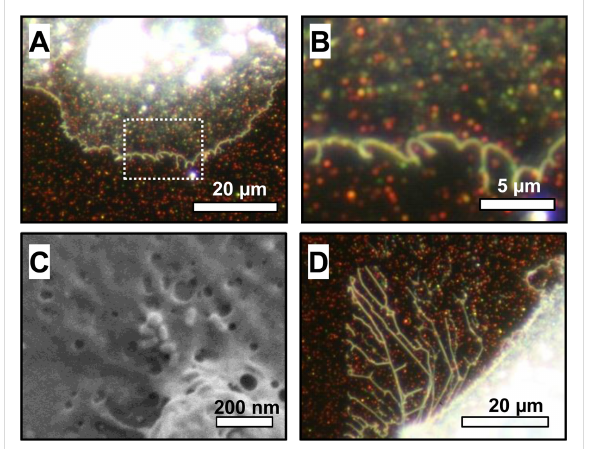
Figure 1: Growth of epithelial cells on a gold nanoparticle-decorated substrate. (A) Optical dark field microscopy detects light scattered by the sample. Gold nanoparticles appear as bright spots with colors corresponding to the plasmon frequency of the particle. The dense inner cell region with the strongly scattering cytoplasm appears bright white. The spread cell membrane is thin and translucent allowing observation of the nanoparticles underneath. (B) Magnified view of the nanoparticles covered with the membrane as marked in (A). (C) Scan- ning electron microscopy image of gold nanoparticles underneath the thin cell membrane. The membrane tightly covers the nanoparticles. (D) Optical dark field microscopy image of an area where the cell membrane has retracted. There are no irregularities or voids in the nanoparticle pattern, indicating that no nanoparticles were displaced. After retraction, a filamentous residue remains attached to the nanorod-decorated substrate. Since these filaments occur in the control samples of bare substrates as well, this behavior does not ne- cessarily indicate an interaction of cell membrane and